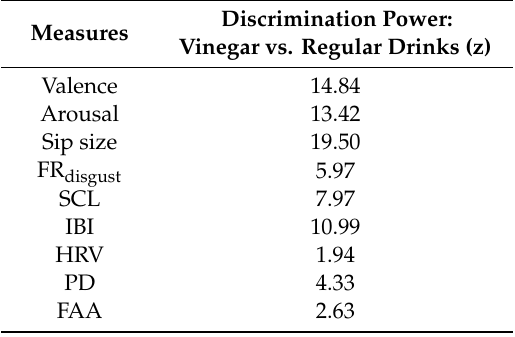
Table 1. Z-scores of each measure between vinegar solution and the regular drinks.